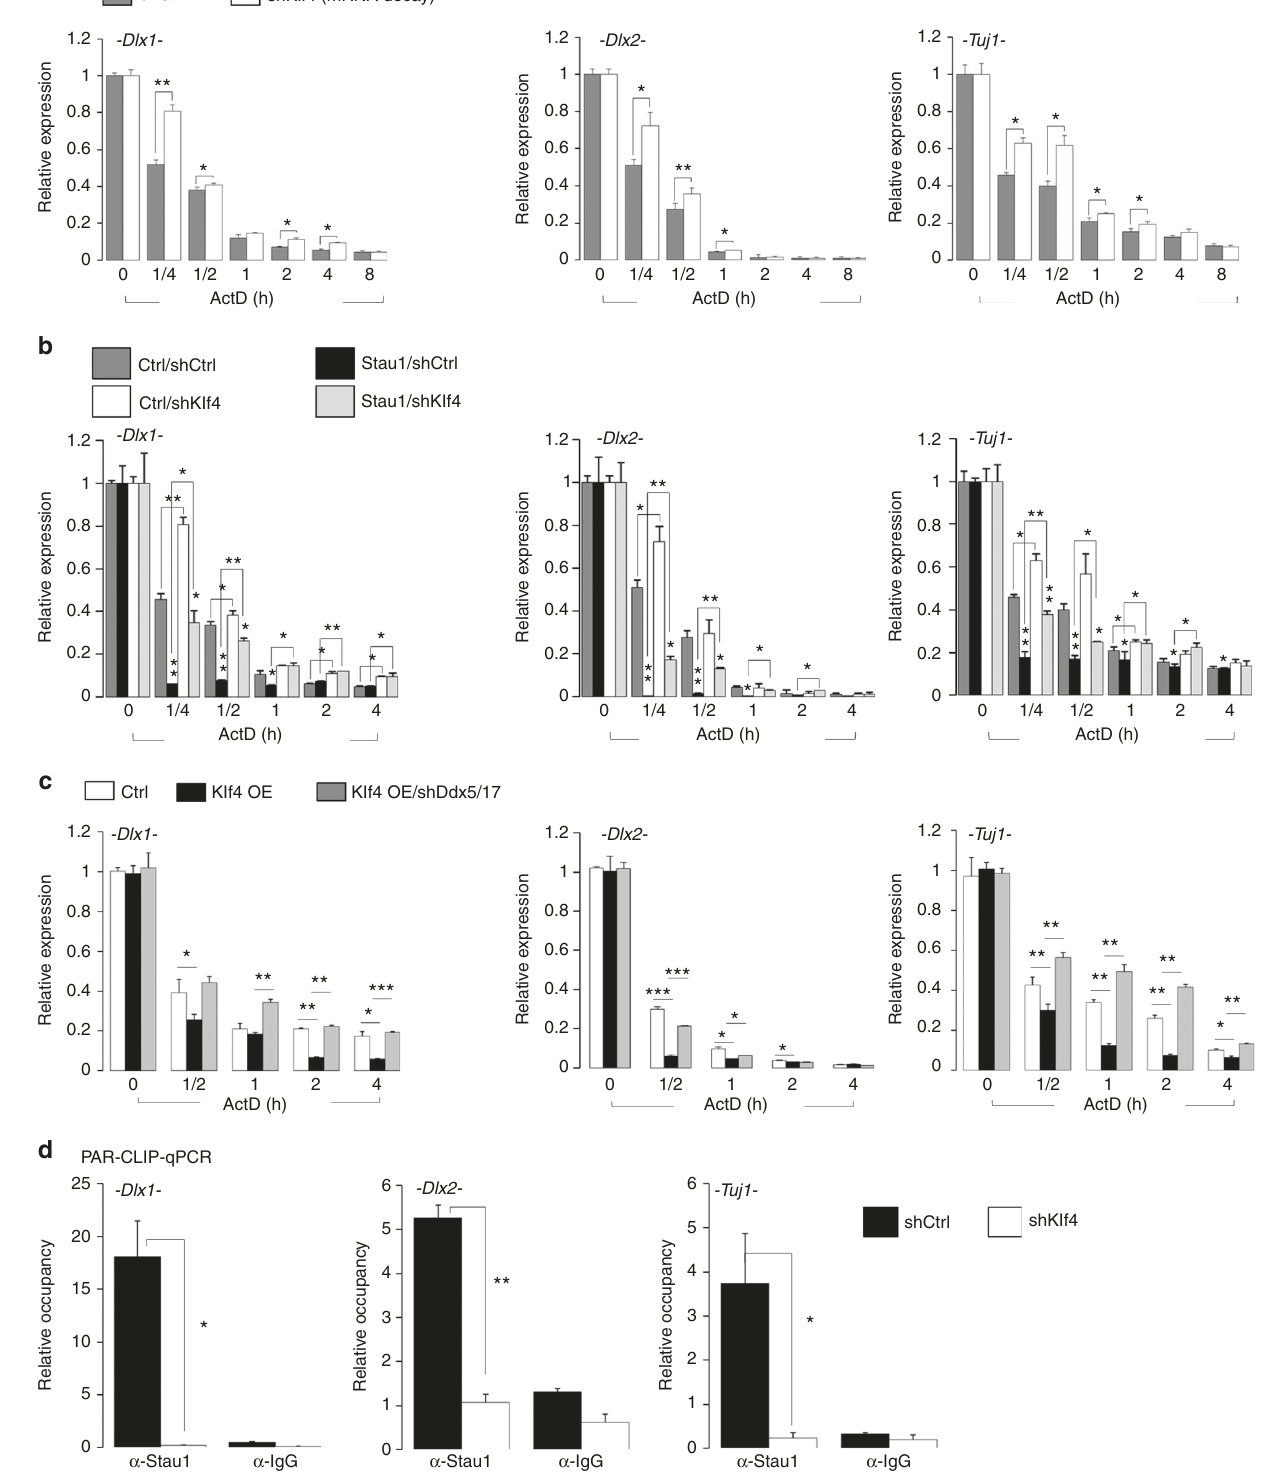
Fig. 6 Klf4 knockdown decreases Stau1 binding to target mRNAs and slows the rate of SMD. a NPCs infected with shScramble or shKlf4 lentivirus were treated with actinomycin D (5 μ g/ml) for indicated times and mRNAs were prepared for RNA stability assays ( n = 3). b RT-qPCR to assess the mRNA decay following Stau1 overexpression in NPCs transduced with shScramble or shKlf4 knockdown constructs. NPCs were treated with actinomycin D (5 μ g/ ml) for indicated times, and mRNAs were prepared for RNA stability assay ( n = 3). c RT-qPCR to assess the mRNA decay at various time points